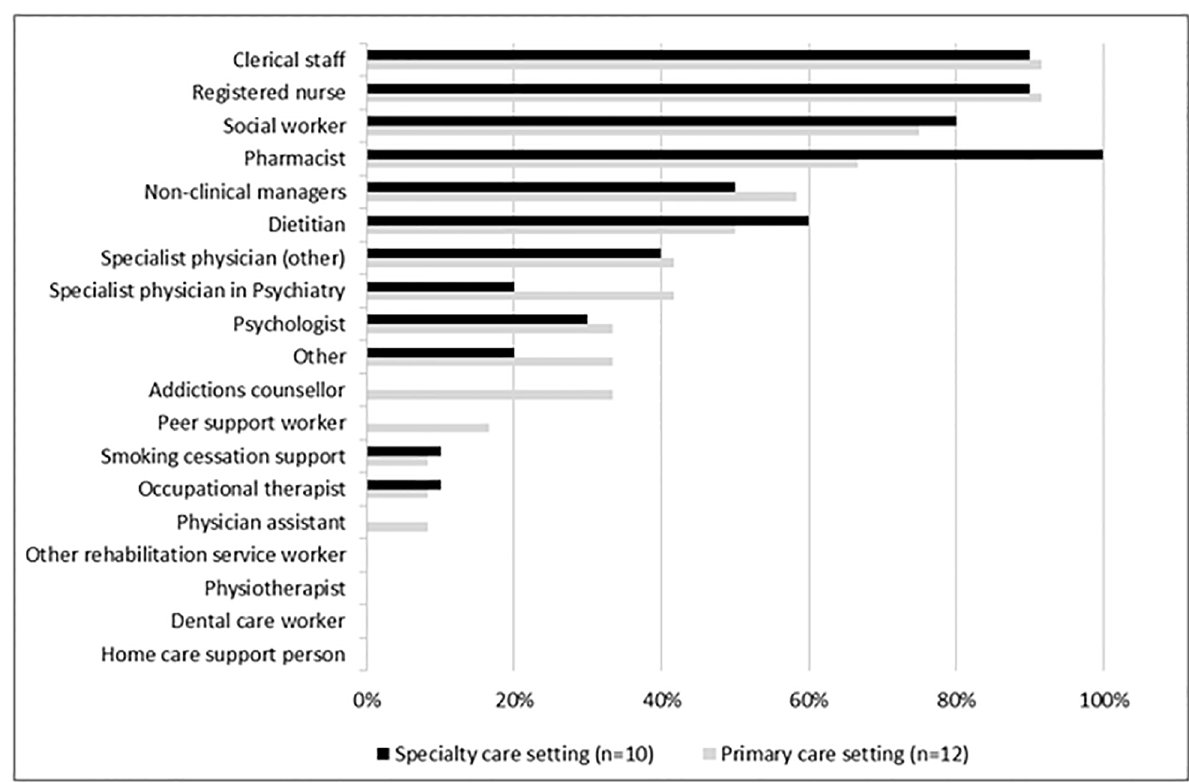
Fig 2. Staffing of primary and specialist care HIV settings. TB = tuberculosis; STI = sexually transmitted diseases; F/U = follow up; IUD = intra uterine device; CDSM = chronic disease self-management; MSK =